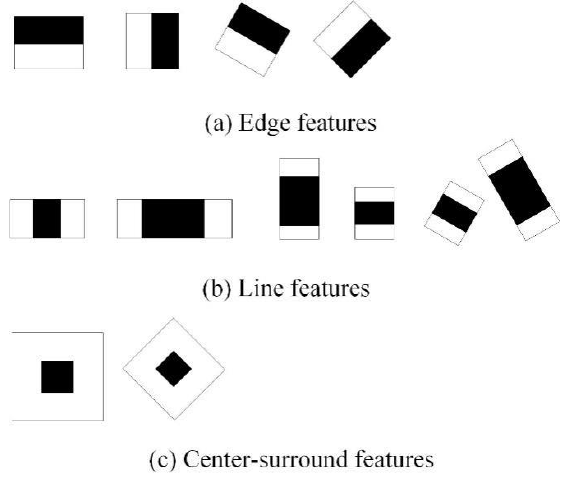
Figure 2. Examples of Haar-like features.